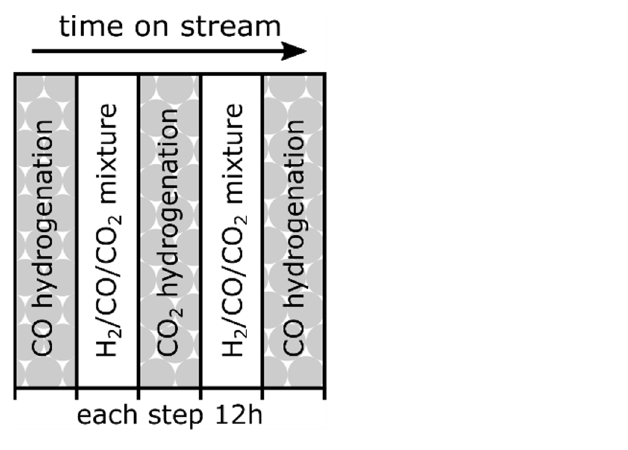
Figure 1. Schematic overview of the experimental campaign after catalyst activation, executed at 350, 370 and 390 °C, respectively.